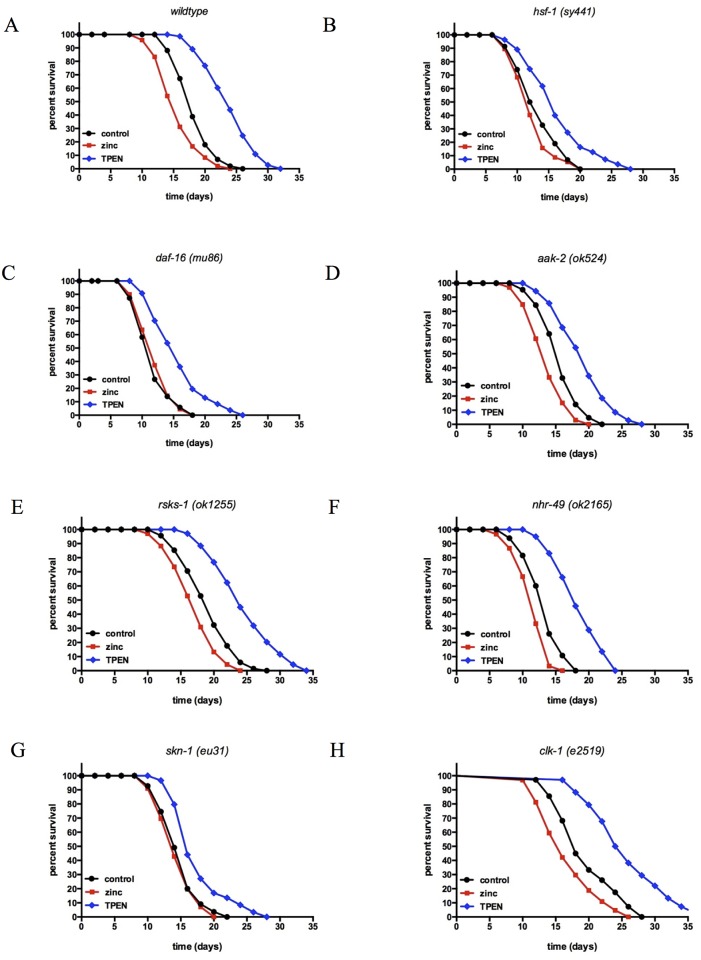
Identification of genes that modulate the effects of zinc and TPEN on lifespan in C. elegans.(A) Wildtype worms, or worms with null alleles for (B)
hsf-1(sy441), (C)
daf-16(mu86), (D)
aak-2(ok524), (E)
rsks-1(ok1255), (F)
nhr-49(ok2165), (G)
skn-1(eu31), and (H)
clk-1(e2519) were exposed to 500μM ZnSO4 or 200μM TPEN at the L3 stage. Mean and maximum population lifespan were reduced with zinc supplementation and increased with TPEN treatment for many mutant strains, similar to wildtype worms (p < 0.0001, log rank test). However, ZnSO4 and TPEN-mediated changes in lifespan were attenuated in worms with mutations of daf-16(mu86), hsf-1(sy441), skn-1(eu31).